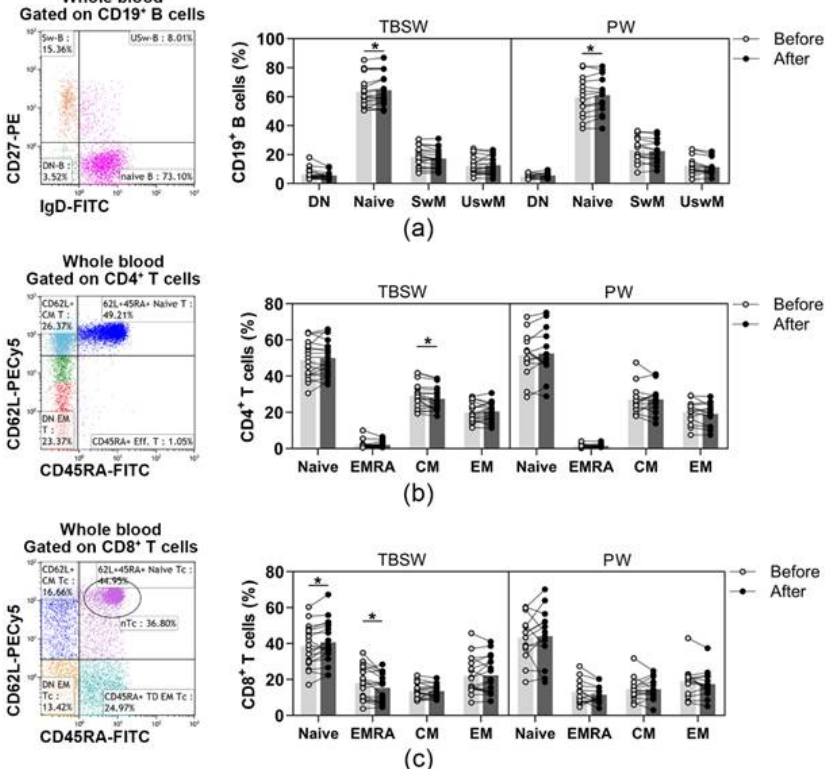
Figure 2. Assessment of naïve and memory lymphocyte subsets in young women after a 14-week workout program. The whole blood of 32 healthy individuals was stained with fluorochrome-labeled monoclonal antibodies, as described previously. According to the exercise courses, the trainees were divided into total-body-shaping workout (TBSW, n = 18) and Pilates workout (PW, n = 14) subgroups. ( a ) Representative dot plot indicates the distribution of IgD + CD27 − naïve, IgD − CD27 − double negative (DN), IgD − CD27 + switched, and IgD + CD27 + un-switched memory B cells. The bar chart shows the percentages of B cell subsets. ( b ) Representative dot plot demonstrates the distribution of CD45RA + CD62L + naïve, CD45RA − CD62L − effector memory (EM), CD45RA − CD62L + central (CM) and CD45RA + CD62L − effector memory (EMRA) Th cells. The bar chart indicates the frequencies of Th cell subpopulations. ( c ) Representative dot plot demonstrates the distribution of CD45RA + CD62L + naïve, CD45RA − CD62L − EM, CD45RA − CD62L + CM and CD45RA + CD62L − EMRA Tc cells. The bar chart indicates the frequencies of Tc cell subpopulations. Repeated measures two-way ANOVA with Bonferroni correction for multiple comparisons was used. Each data point represents an individual subject, while bars show the mean values. Statistically significant differences are indicated by * p <